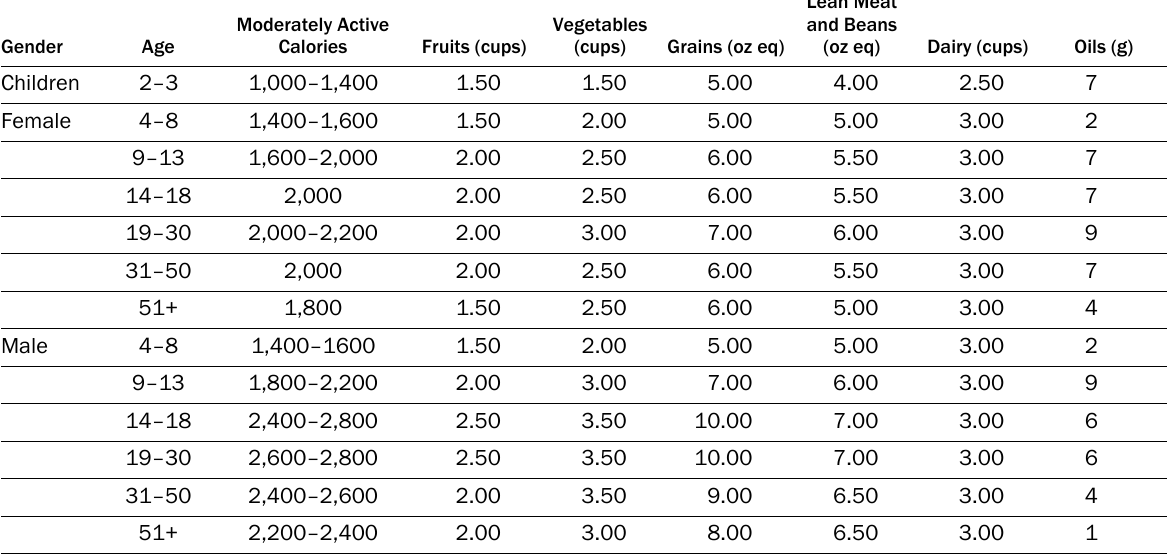
Table 2. Dietary Guidelines by Age and Gender for Moderately Active Persons by Food Group (daily